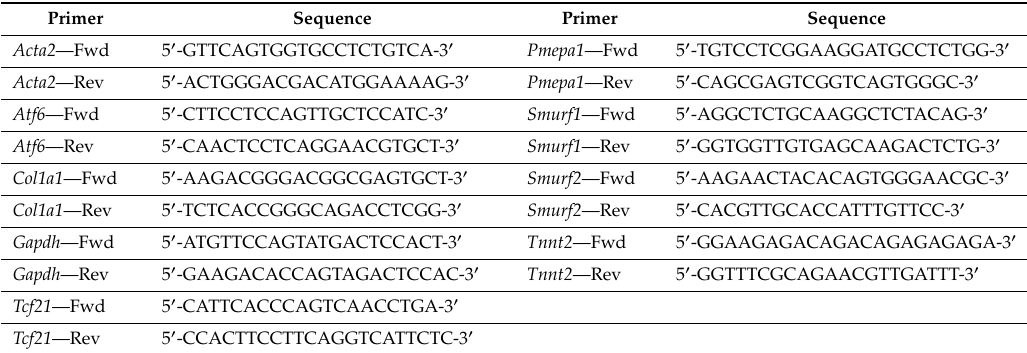
Table 1. Forward and reverse primers used for qRT-PCR, listed 5 (cid:48) to 3 (cid:48)